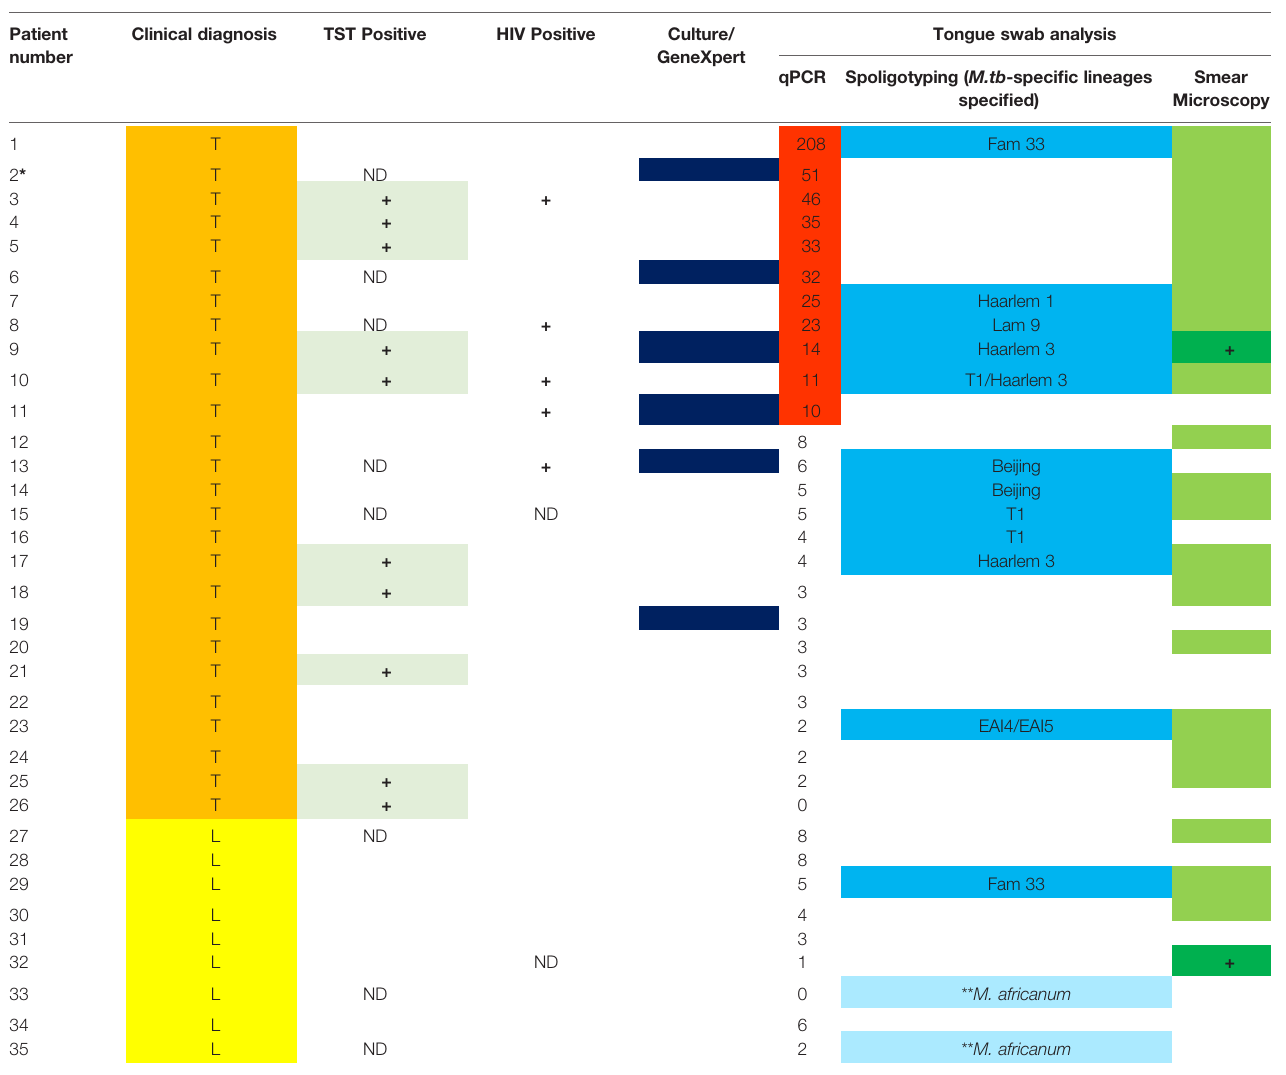
TABLE 2 | Detection of Mycobacterium tuberculosis complex bacilli and nucleic acids from tongue swabs in young, hospitalized children with clinically diagnosed tuberculosis ( “ T ” ; orange) or lower respiratory tract infection ( “ L ” ;